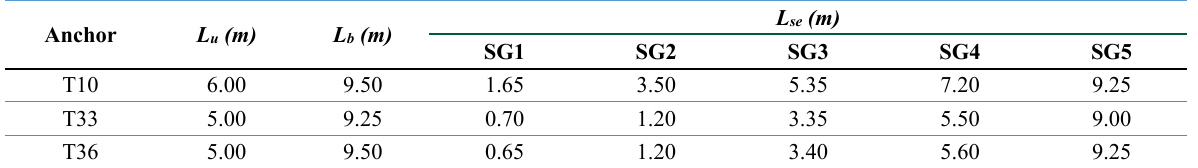
Table 2 - Positions of the instrumented sections in the anchor bonded